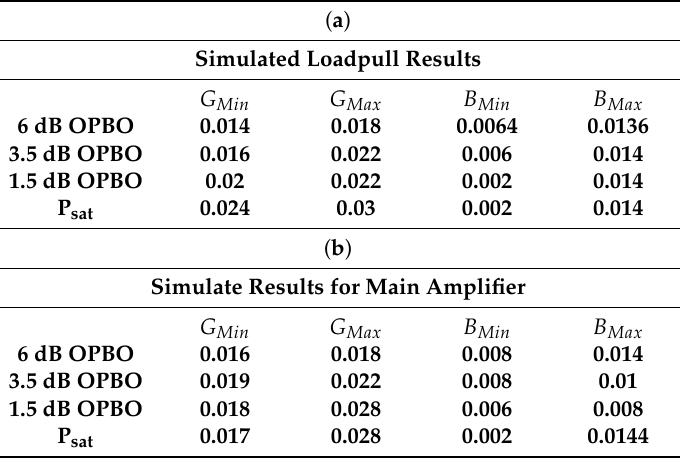
Table 1. Min and Max values for the load admittance, Y Load = G L +jB L . ( a ) Load limits extracted from simulated Loadpull. ( b ) Min and Max load values for the circuit in Figure 9.